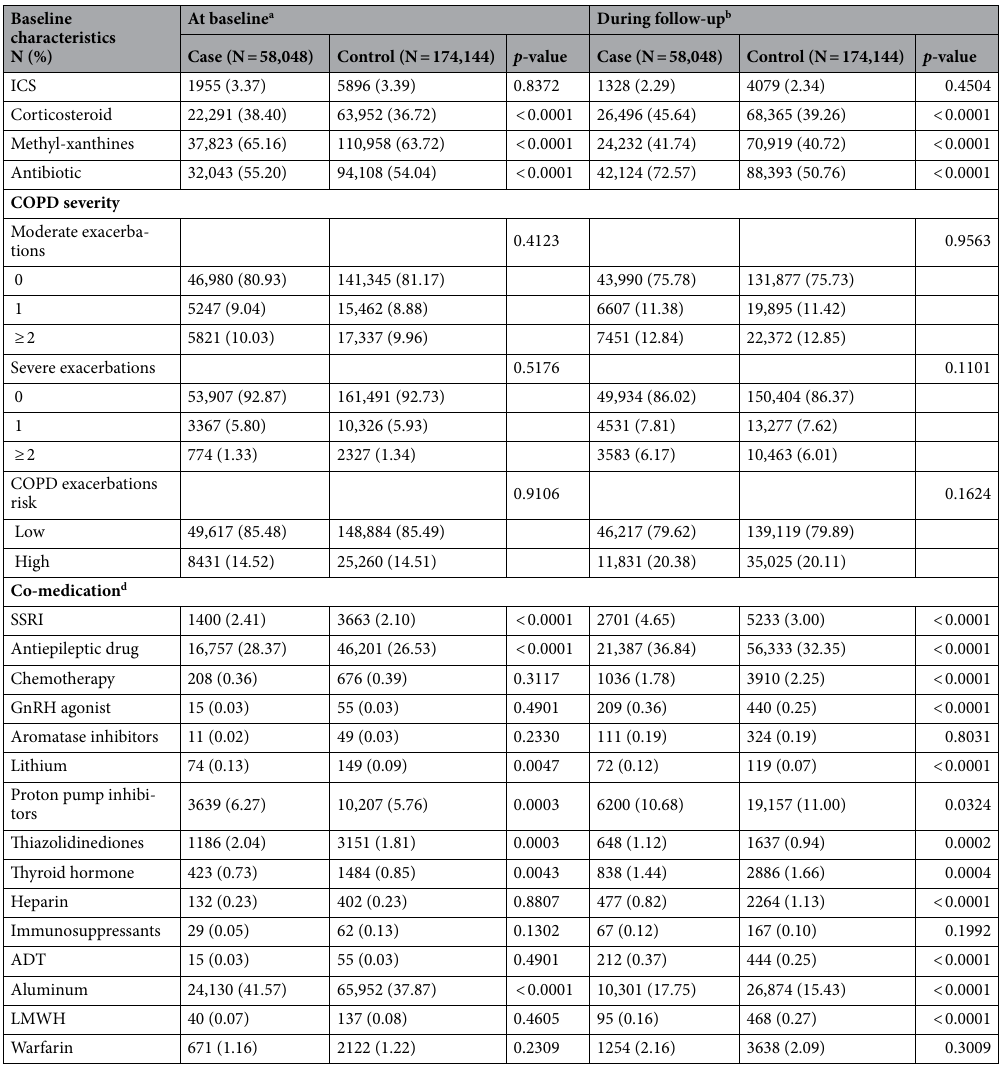
Table 1. Baseline characteristic between cases and matched controls. LABA long-acting beta-agonist, ICS inhaled corticosteroids, LAMA long-acting muscarinic antagonists, SABA short-acting beta-agonist,